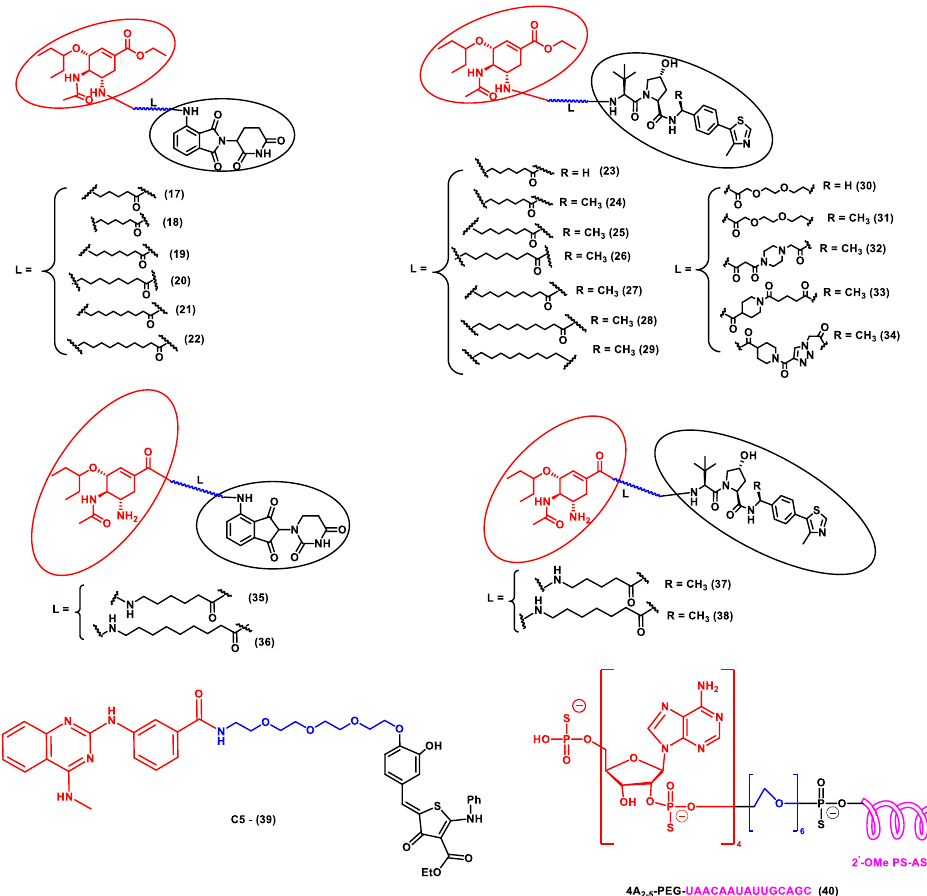
Figure 4. Structures of the PROTAC molecules are used for the degradation of viral proteins. The red circle indicates the POI ligand; the blue wavy line indicates the linker; the black circles indicate the E3 ligand moiety.